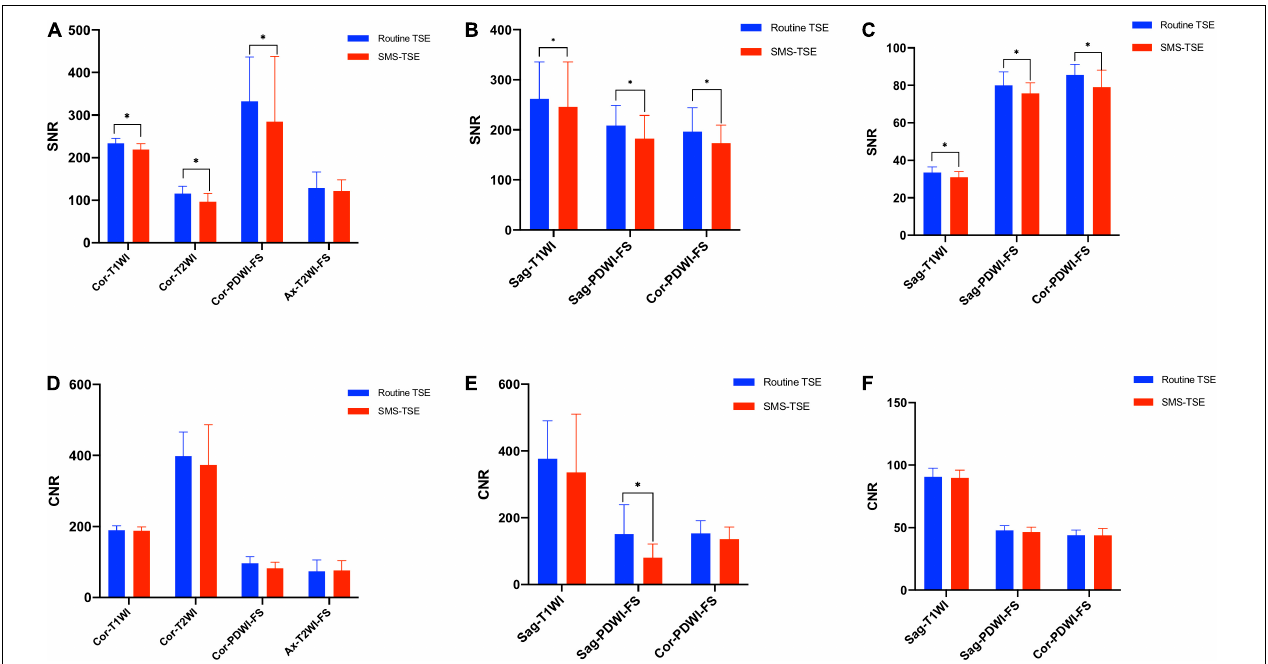
FIGURE 4 | Quantitative comparison of the SNR and CNR between the high-resolution turbo spin-echo (TSE) sequence and simultaneous multi-slice-TSE imaging. The SNR of the wrist (A) , ankle (B), and knee (C) obtained with routine TSE sequences were significantly higher than SMS-TSE sequences except for the Cor-PDWI-FS sequence in wrist joint. No differences were obtained with CNR for the wrist (D) , ankle (E) , and knee (F) between the routine TSE sequences and SMS-TSE sequences except for the Sag-PDWI-FS sequence in ankle joint. “*” p < 0.05.